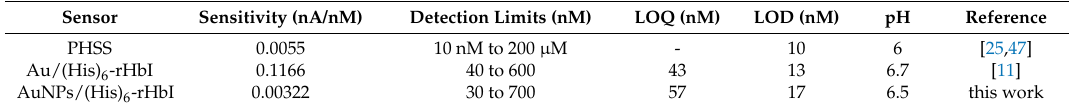
Table 3. Performance characteristic of H 2 S-electrochemical sensors.